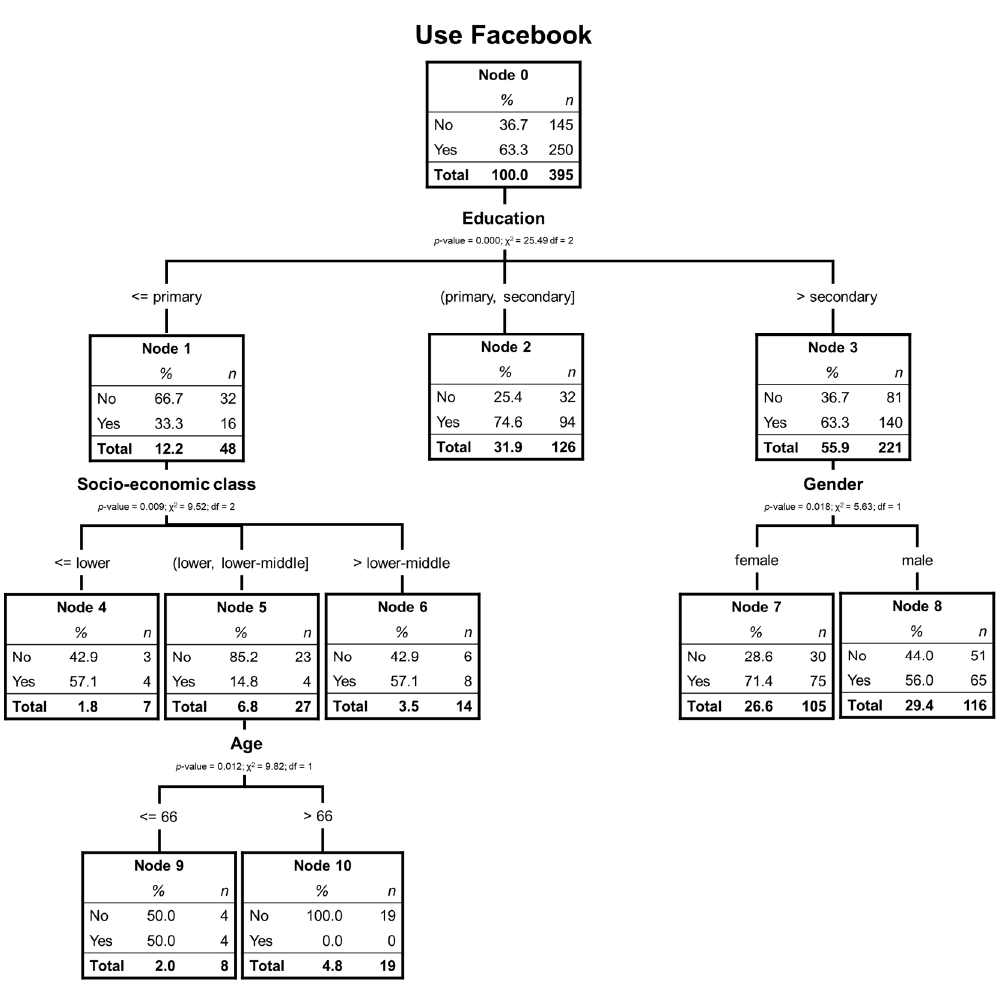
Figure 2. Decision tree of elderly Facebook users.